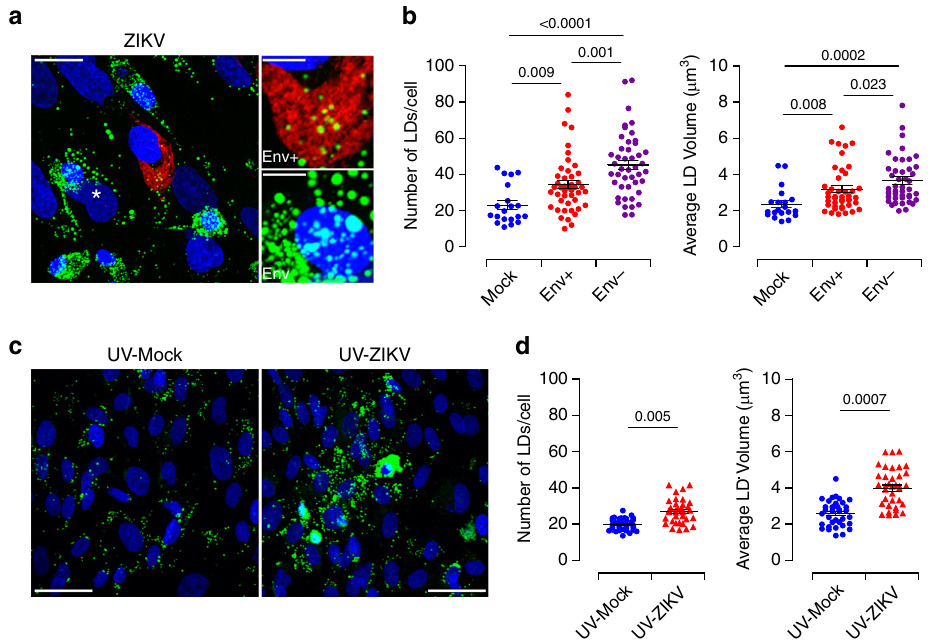
Fig. 5 Bystander effect of ZIKV infection on LD biogenesis. Placental cells were infected with ZIKV MOI of 1 for fi ve days. a LD staining with the BODIPY 493/503 dye (green), anti-Flavivirus group antigen antibodies (Env) staining distinguishes ZIKV + (red) from ZIKV − bystander cells (asterisk). High- magnitude images of LD are shown in the right panels. Scale bar, 20 μ m. High magni fi cation image insets showing LDs in both ZIKV + (Env + ) and ZIKV − (Env − ) bystander. Scale bar, 5 μ m. b Morphometric measurements of LD number and volume based on Z-stack projections of confocal images. Data from fi ve different donors are shown as dot plot graphs. Each data point represents the average number of LDs per cell and average volume from mock (blue) and ZIKV-infected cells (red) or bystander neighboring cells (violet). Results are presented as mean values ± SEM and analyzed by one-way ANOVA, with Dunnett ’ s multiple comparison test. c Supernatants from mock- or ZIKV-infected primary placental cells were collected from fi ve independent donors 5 dpi and UV-irradiated. Freshly isolated placental cells are challenged with the UV-irradiated supernatants for 3 days. Immuno fl uorescence staining of LDs with the BODIPY 493/503 dye (green), ZIKV Env protein (red) and nuclei (DAPI in blue). Scale bar, 50 μ m. d LD number and volume analysis by Imaris software. Each data point represents the average number of LDs per cells and average volume from Mock- (blue) and ZIKV + cells (red). Results are presented as mean values ± SEM and analyzed by two-tailed Student ’ s t test. Source data are provided as a Source Data fi